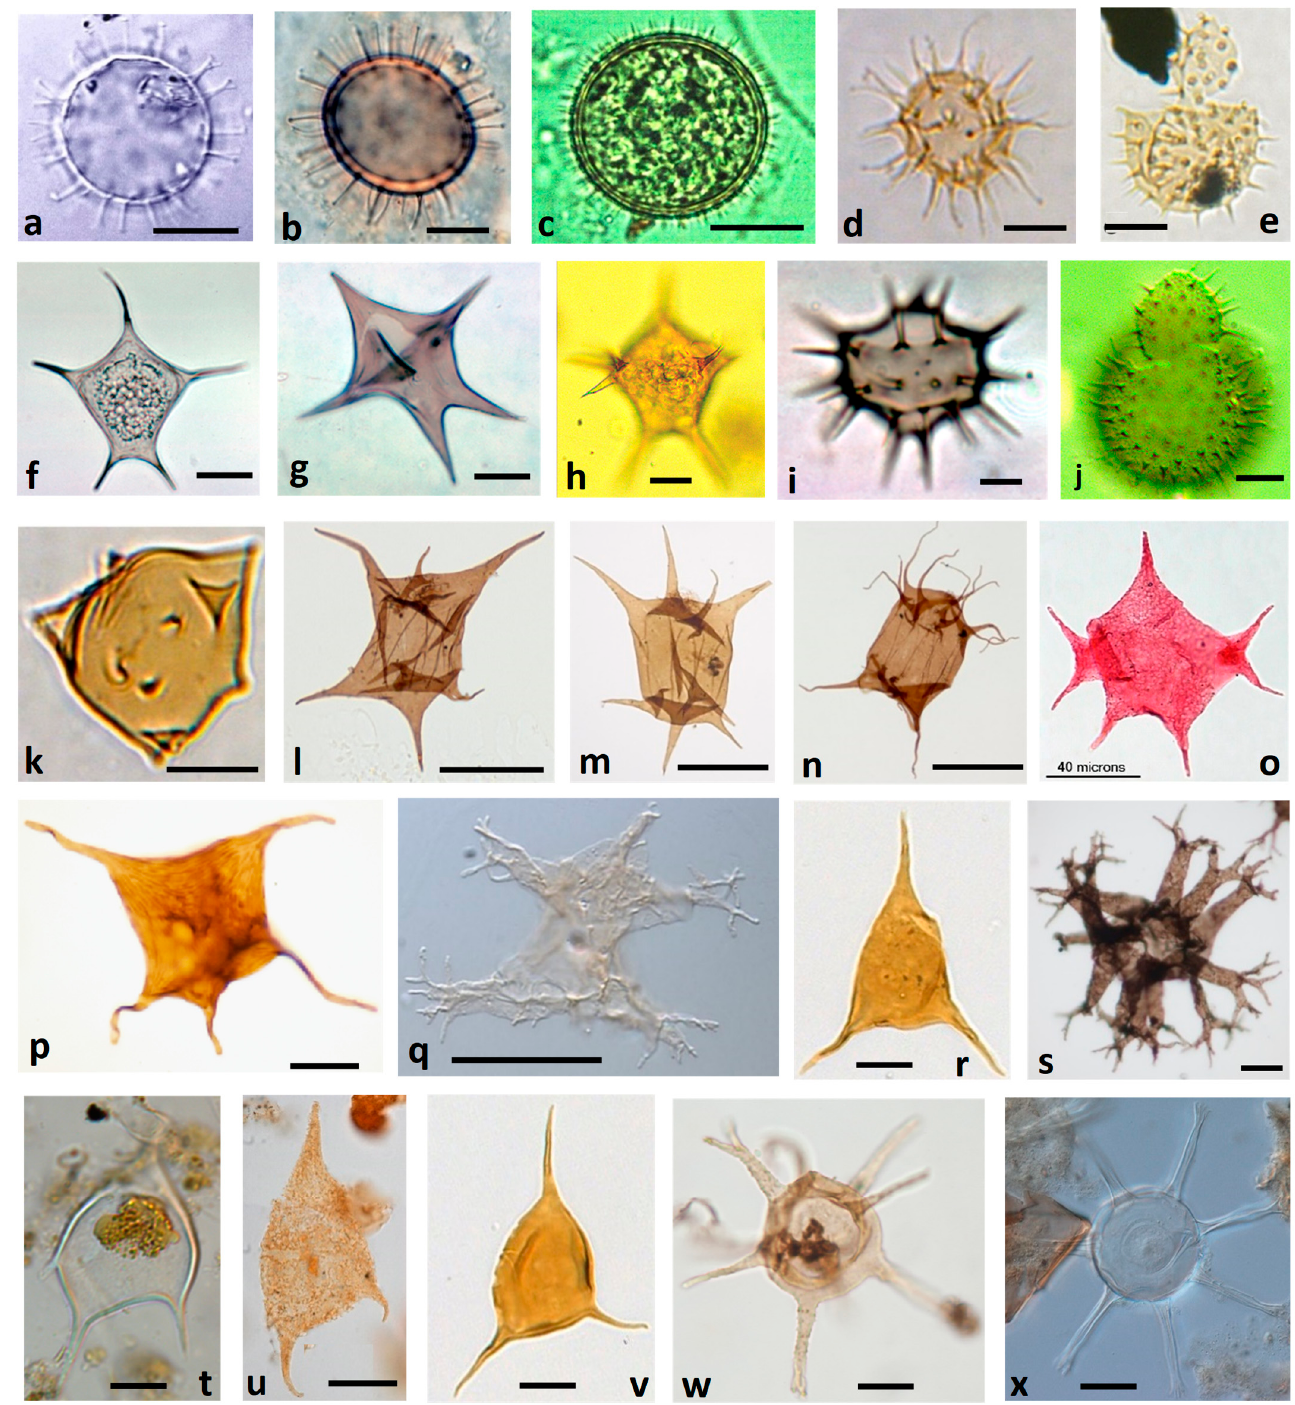
Figure 3. Comparable morphologies in living cysts, fossil cysts, and acritarchs. ( a – e , j ) living and fossil Micrhystridium and Micrhystridium-like dinoflagellate cysts; ( a ) living cyst of Pentapharsodinium dalei , ( b ) living small spiny cyst of Echinidinium aculeatum , ( c ) living cyst of athecate Polykrikos hartmanii , ( d , e ) acritarchs, ( e ) with split archeopyle (L. Permian/E. Triassic); ( f – i ) living cysts ( Protoperidinium ) with processes reflecting horns and cingulum of motile stage; ( f ) Stelladinium stellata with processes reflecting horns and shoulders, ( g , h ) Stelladinium robusta ,with processes also reflecting the cingulum, ( i ) P. conicum with processes reflecting cingulum, ( j ) living cyst with split archeopyle comparable with acritarch in e above, ( k – q ) acritarchs and fossil cysts with processes reflecting horns,